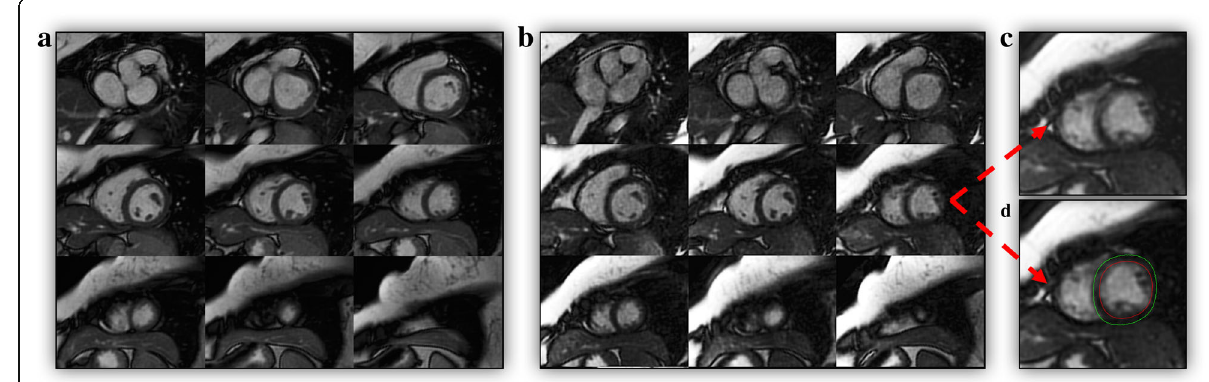
Fig. 1 Short-axis images acquired using 2D-SSDFP ( a ) and accelerated k-t SENSE sequence ( b ). Presence of blurring/mis-triggering ( c ) in LV apical slices of accelerated k-t SENSE cine and endocardial/epicardial contours manually corrected ( d